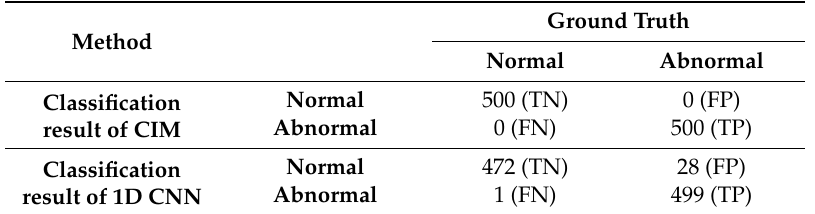
Table 4. Comparison of c onfusion matrices between CIM approach and 1D CNN approach.